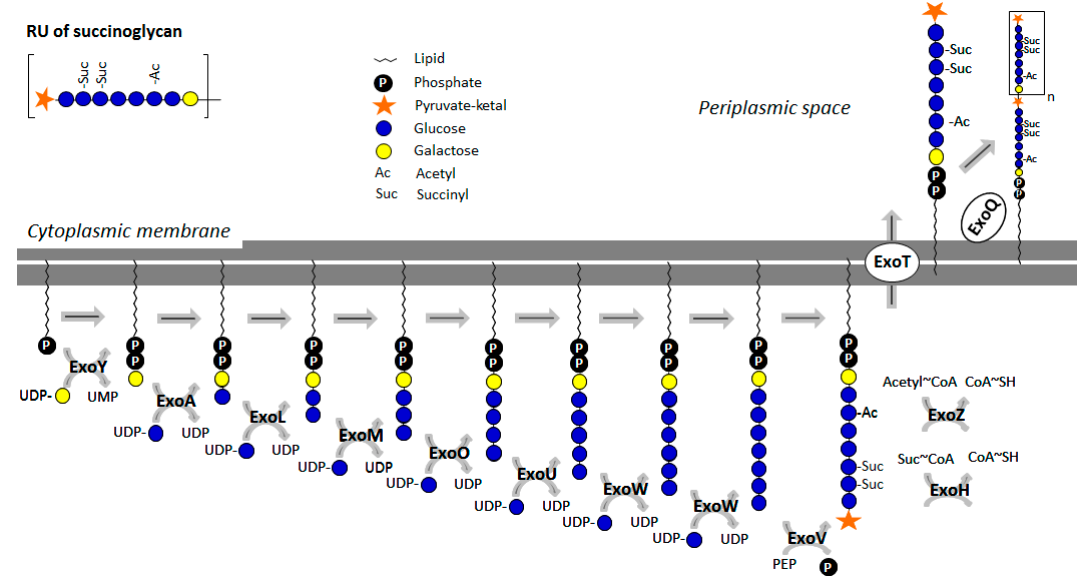
Figure 2. Scheme of succinoglycan biosynthesis in Shinorhizobium meliloti [43]. The pyruvylation step occurs in the cytoplasm at the stage of the undp-PP-linked RU prior to export and polymerization in the periplasmic space. Pyruvylation (ExoV) is indicated by a star. The order of pyruvylation, acetylation (ExoZ), and succinylation (Exo) is unknown. RU: repeating unit. Monosaccharide symbols are shown according to the Symbol Nomenclature for Glycans (SNFG) [45].